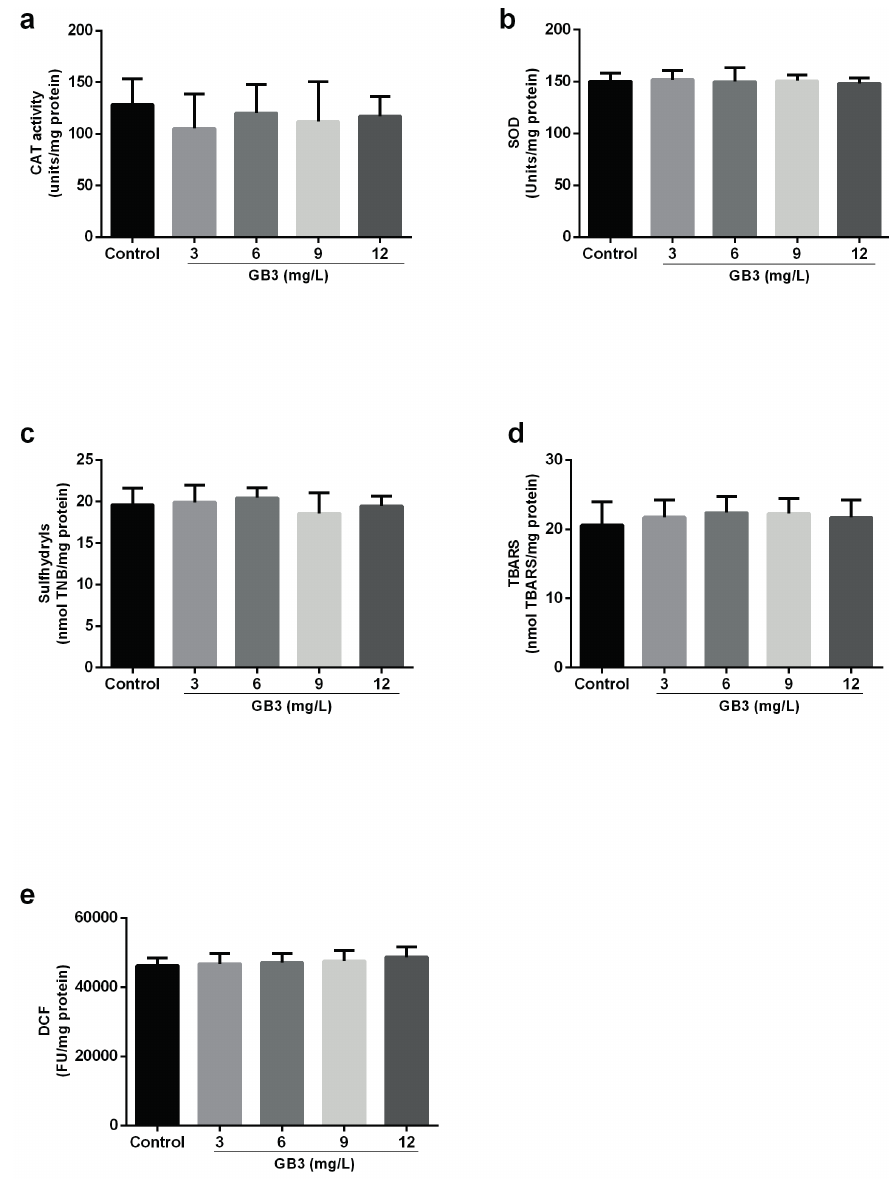
Figure 3 - In vitro effect of GB3 on catalase (CAT) activity ( a ), Superoxido dismutase (SOD) activity ( b ), sulfhydryl assay ( c ), lipoperoxidation ( d ) and production of reactive species ( e ) in liver of Wistar rats. Values are means ± S.D.